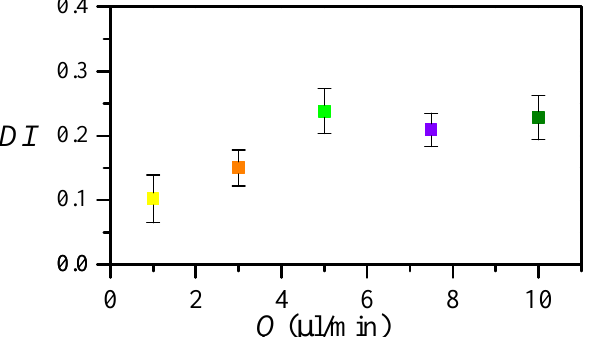
Figure 12. Temporal evolution of the particle deformation (symbols) and numerically calculated strain rate (lines) for nozzle 8 ( a ), 6 (blue) and 7 (cyan) ( b ), and 6 (blue) and 4 (red) ( c ). The flow rate was Q = 5 µ L/min.